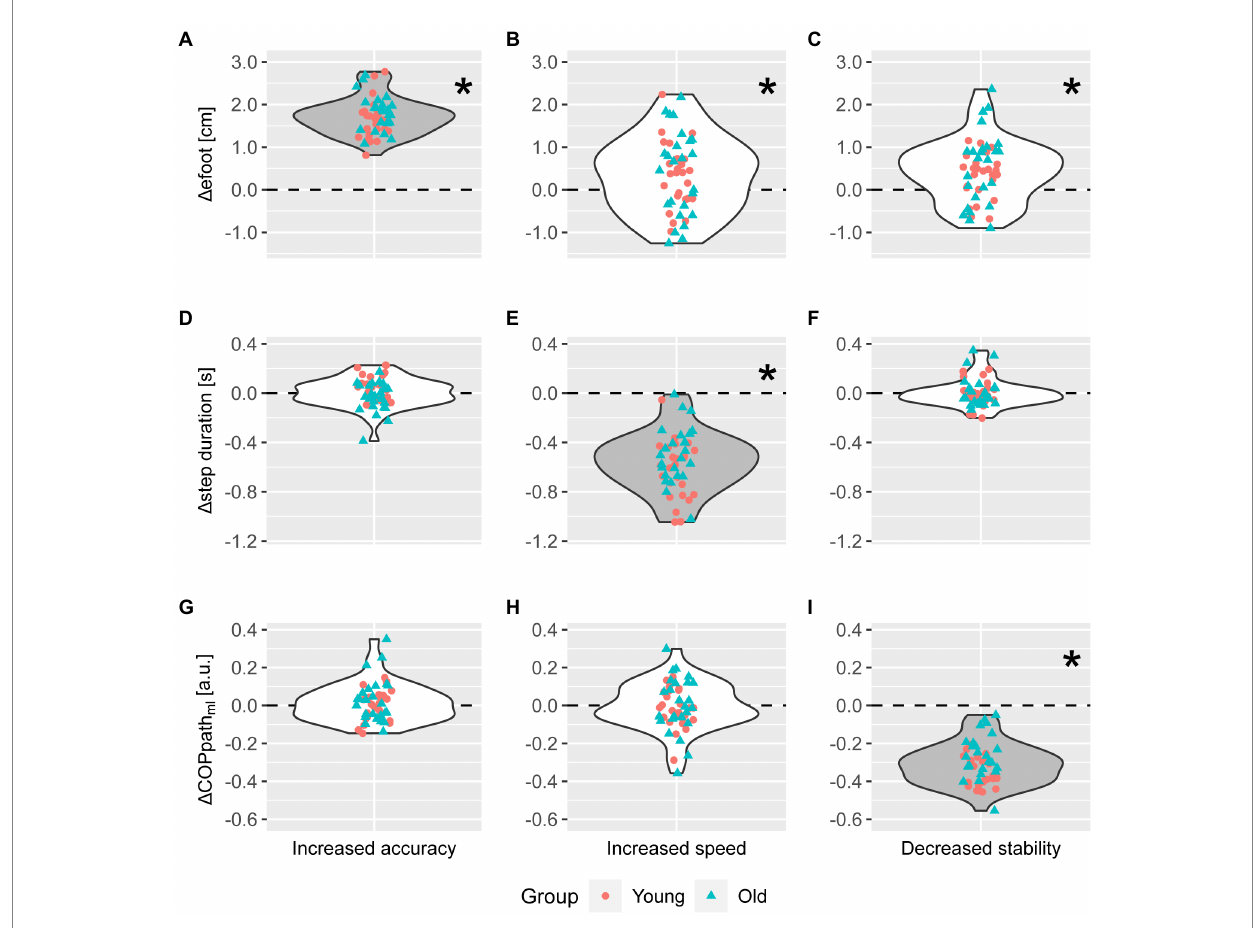
FIGURE 2 Stepping outcomes with increasing task-demands. Circles and triangles represent individual data points for young and older adults, respectively. Plots show the change in foot placement error, step duration, and mediolateral center of pressure path length (in the rows in top-to-bottom order) as a result of increasing accuracy, speed, and stability demands (in the columns in left-to-right order). Panels (A,E,I) , show changes in task-level goal performance (i.e., stepping outcomes) on task-goals in which demand was increased. These plots thus show the effectiveness of increasing task demands. E.g. panel (E) shows whether increasing demand on speed successfully decreased step duration. Panels (B–H) show the change in stepping performance resulting from task-level goal trade-offs, i.e., the extent to which increased demand on one task goal leads to decreased performance on the others. E.g. panel (B) illustrates the change in foot placement error resulting from increasing speed, i.e., the speed-accuracy trade-off. *Indicates when increasing stepping demands resulted in a change in stepping outcomes that was statistically significant different from zero after correcting for multiple